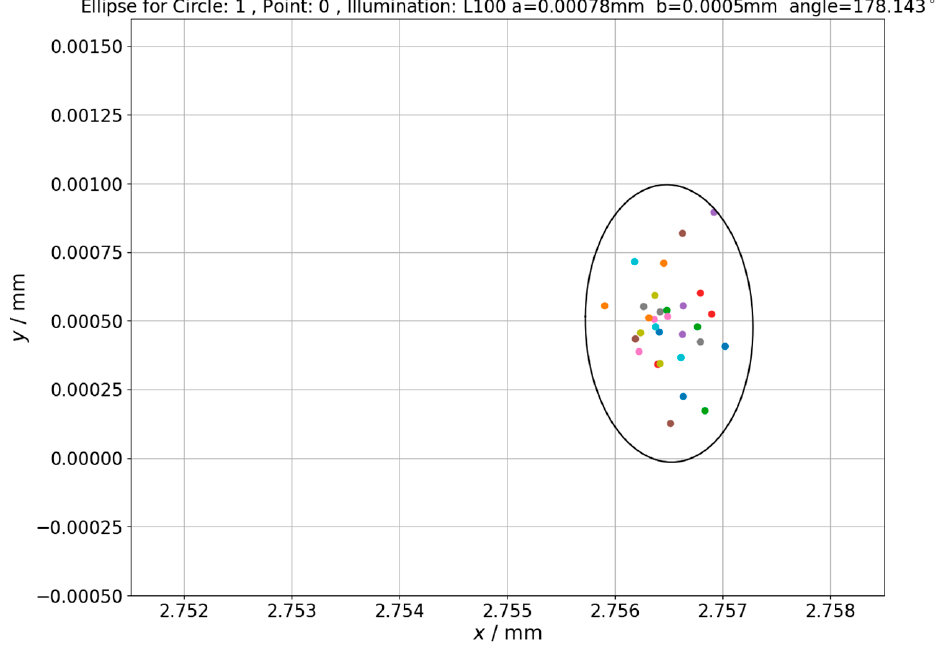
Figure 12. The ellipse of point repeatability obtained for first point in measurement routine. Hole plate standard measurements—Circle 1. Applied illumination L100.